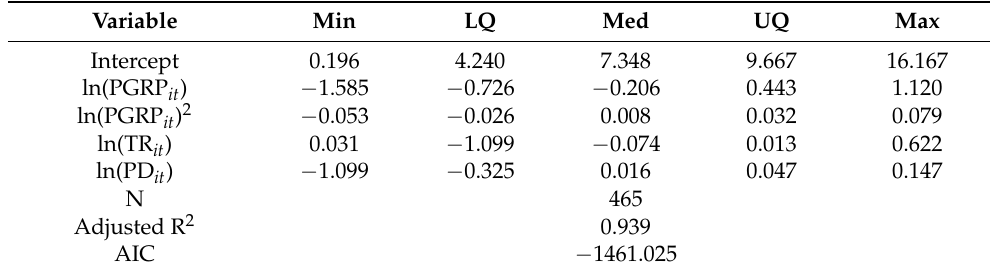
Table 4. Estimation Results of GWR